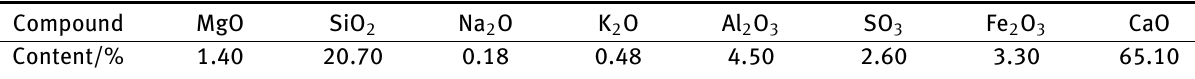
Table 2: Characteristics of the cement.